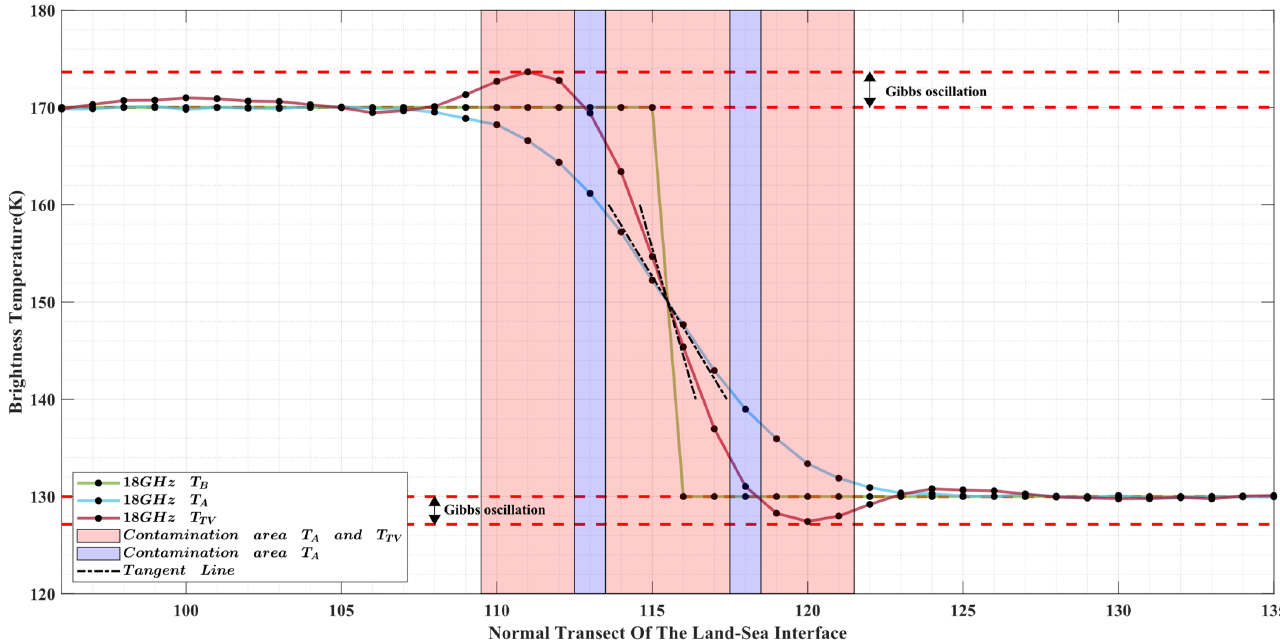
Figure 2. Pictorial view of the Resolution Factor and contamination area with the normal transect near the abrupt discontinuity.